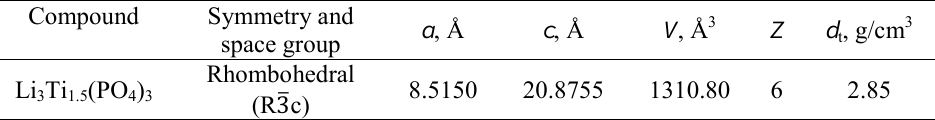
Table 1: Summary of X-ray diffraction results for Li 3 Ti 1.5 (PO 4 ) 3 compounds at room